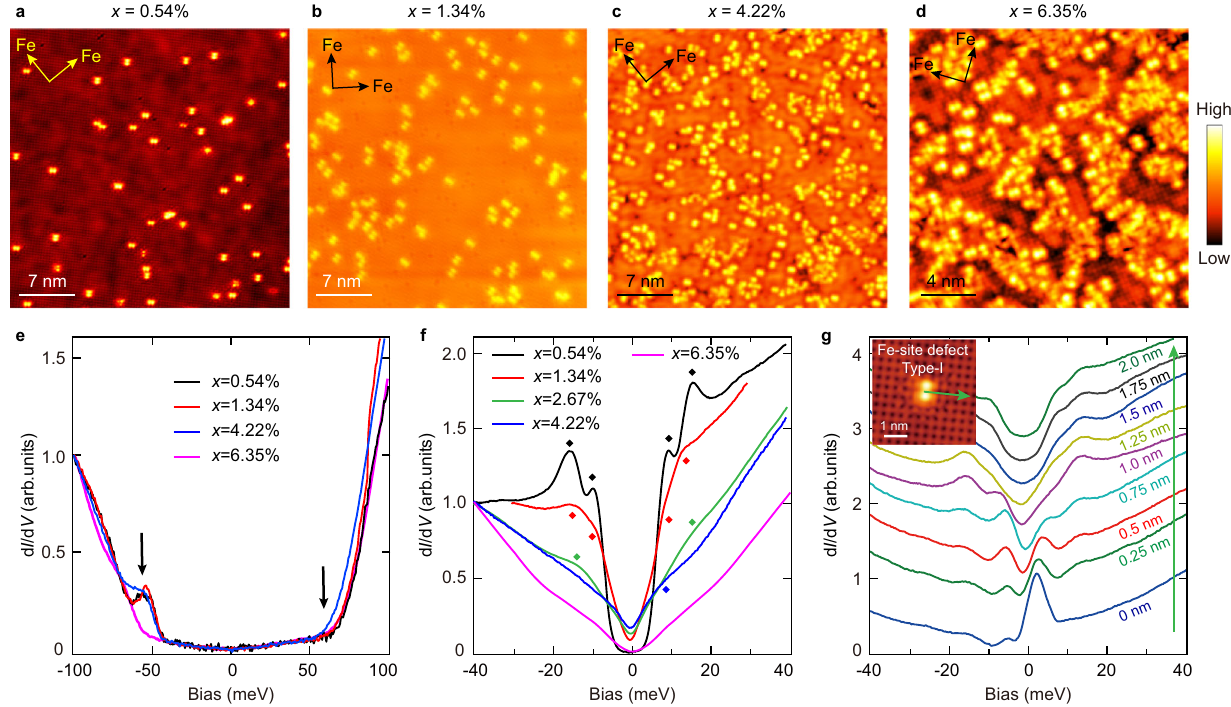
Fig. 1 | Typical topographic images and d I /d V spectra for Fe 1 − x Se regions with varying x values. a – d Atomically resolved topographic images of four Fe 1 − x Se regions. Measurement conditions: a V b =0.5V, I t =60 pA; b V b = − 0.55V, I t =20 pA; c V b =0.1V, I t =10 pA; d V b =0.1V, I t =50 pA. e Typical d I /d V spectra within ±100meVcollectedindefect-freeFeSeregions( V b =100mV, I t =80pA, Δ V =2mV). Black arrows indicate the onsets of energy bands. f Averaged d I /d V spectra within ±40meVcollectedindefect-freeFeSeregions.Thediamondsmarkthepositionsof